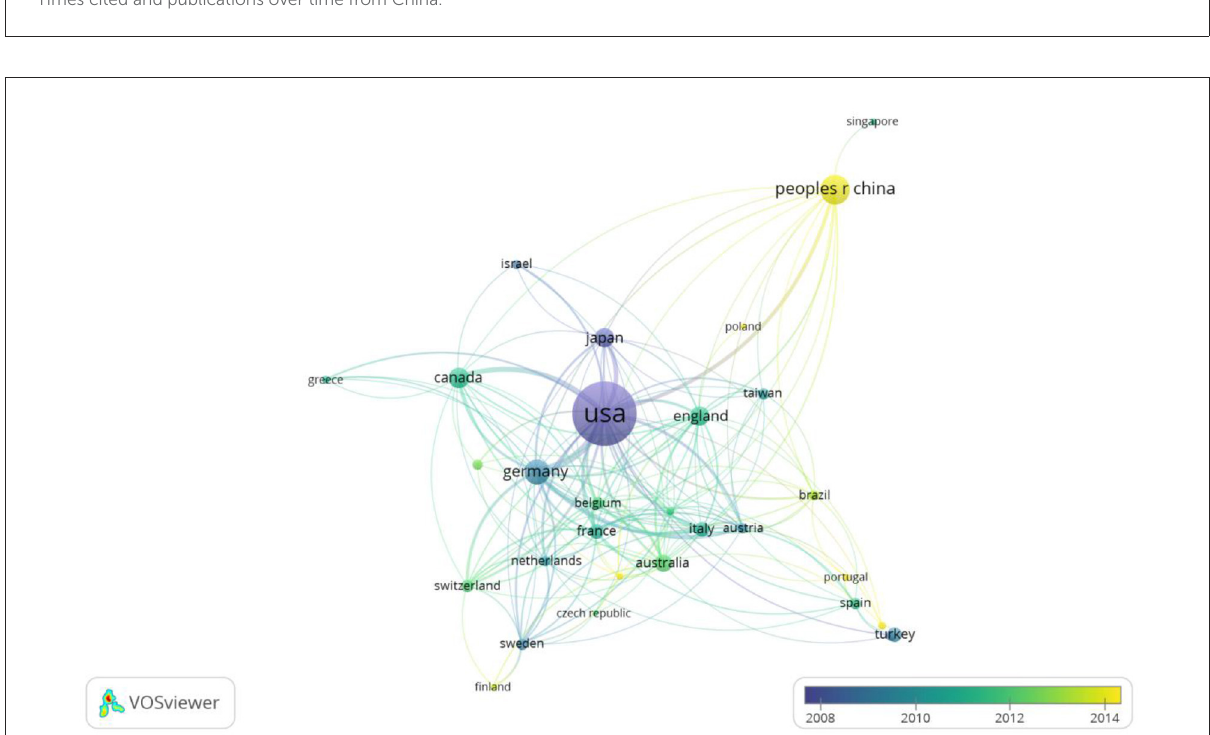
FIGURE4 Bibliographic analysis and development of countries with respect to time from more than ten records. Node size represents the number of publications; color represents the average publication year; distance only represents the link strength between two